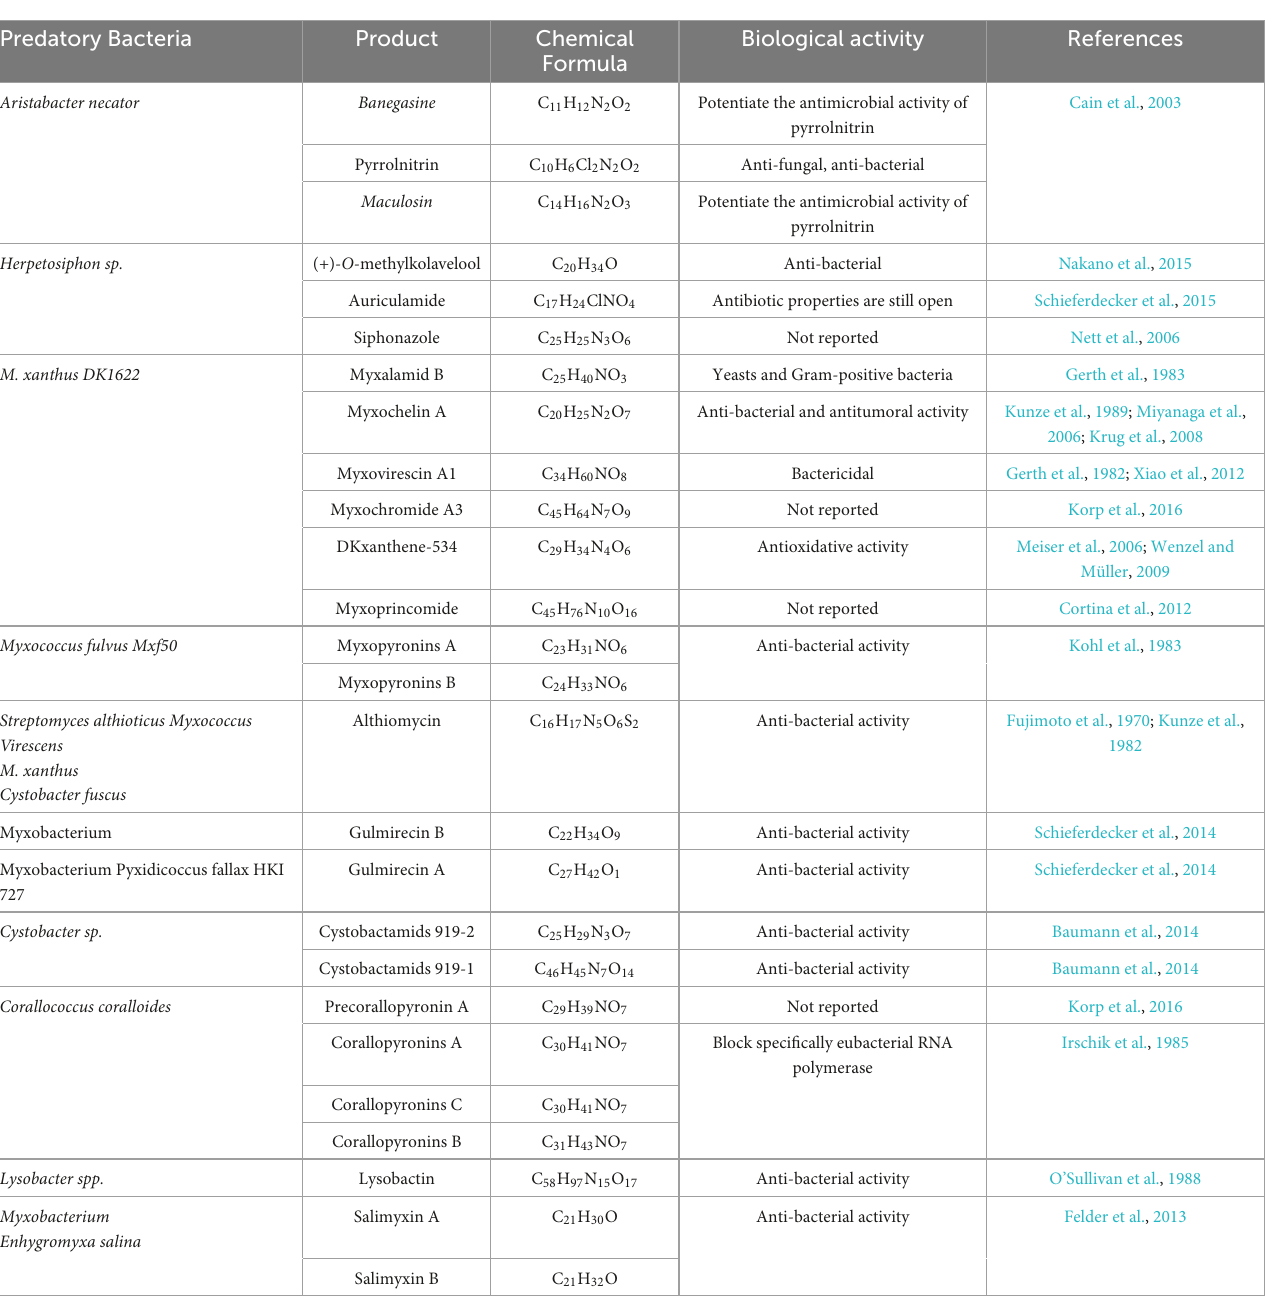
TABLE 2 Secondary metabolites from different predatory bacteria and their biological activity. Predatory